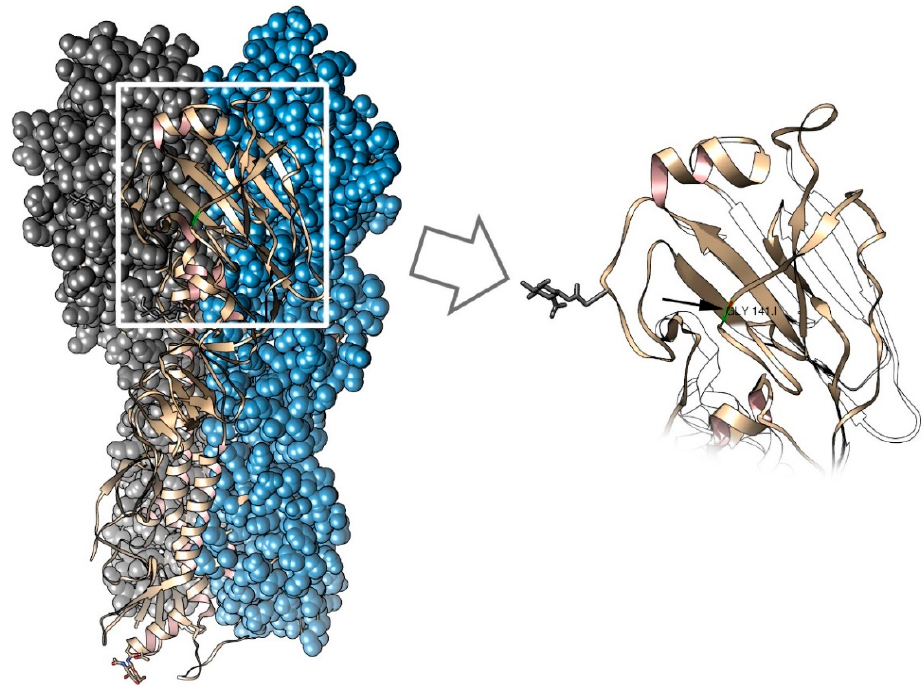
Figure 4. Mapping of the Gly 141 position on the B/Brisbane/60/2008 HA structure. Left: HA trimer, monomers are shown by different colors. Right: the receptor binding site area. The black arrow points to the 141 position. The figure was prepared on the base of PDB 4fqm [42] using Chimera 1.14 software.